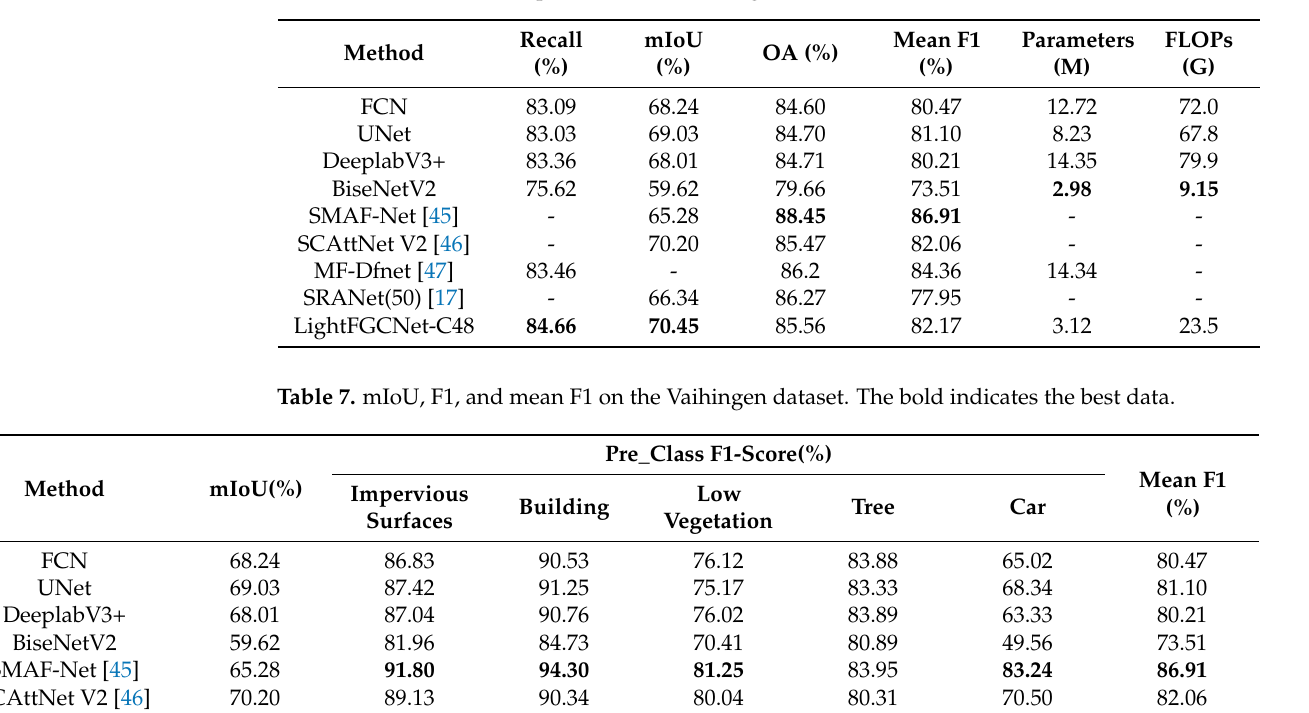
Table 6. Performance comparison on the Vaihingen dataset. The bold indicates the best data.